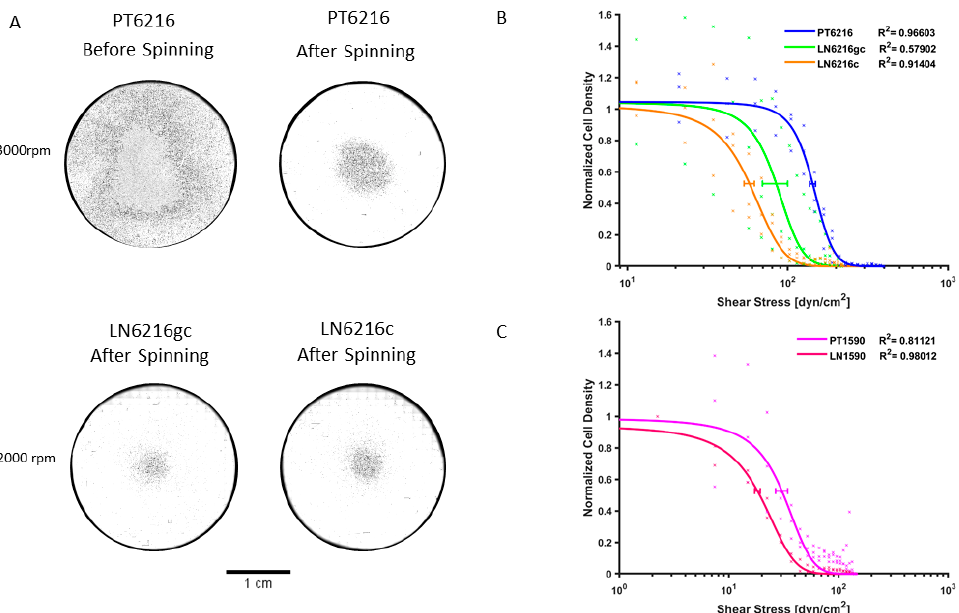
Figure 2. Adhesiveness of primary tumor and metastatic esophageal cells. We performed a shear stress adhesion assay. ( A ) The spinning disks seeded with PT6216 before and after spinning at 3000 rpm as well as disks with LN6216gc and LN6216c after spinning at 2000 rpm. The difference in rotational speed is due to the different adhesive properties of primary and lymph node cells. τ 50 was calculated independently of this and reached a value of 143.28 ± 6.01 dyn/cm 2 for PT6216 cell. τ 50 was much lower for metastatic cell lines, 84.72 ± 15.04 dyn/cm 2 for LN6216gc and 57.72 ± 4.26 dyn/cm 2 for LN6216c cells. Less shear stress was necessary to detach LN6216gc and LN6216c cells in comparison to PT6216 cells. ( B ) Error bars represent the 95% confidence interval of τ 50 calcu- lated by the global fit. ( C ) τ 50 was lower for the metastatic cell line LN1590 with 18.28 ± 1.10 dyn/cm 2 than for primary tumor cell line PT1590 with 30.52 ± 3.81 dyn/cm 2 cells. Less shear stress was necessary to detach LN1590 cells in comparison to PT1590 cells. 4. Discussion While the incidence of esophageal adenocarcinoma in the Western countries is con- tinuously increasing, the 5-year mortality rate remains poor [1,21]. Clinically, multimodal therapy concepts are continuously reevaluated and improved. Nevertheless, mortality in patients with solid tumors is often associated with metastatic spread. In the light of this, scientific efforts should focus on understanding the metastatic process in order to stop or prevent metastases. Tumor cell dissemination is a highly complex process of which not all steps are fully understood yet. While some aspects such as tumor cell invasion, extrav- asation, migration, and homing have been identified, it remains unclear how these tumor cell attributes work together in actual cell dissemination. Mechanisms targeting specific cell attributes have been described, and new targeted as well as immuno-therapies are emerging. We previously identified HER2 and CXCR4 as possible alternative targets in the treatment of esophageal carcinoma and associated mild hypoxia leading to expression of CAIX with increased metastatic spread [2,22–25]. There is, however, no universal molec- ular marker on the basis of which metastases can be treated. More recently, biophysical cell attributes that contribute to tumor cell dissemination have become of interest.